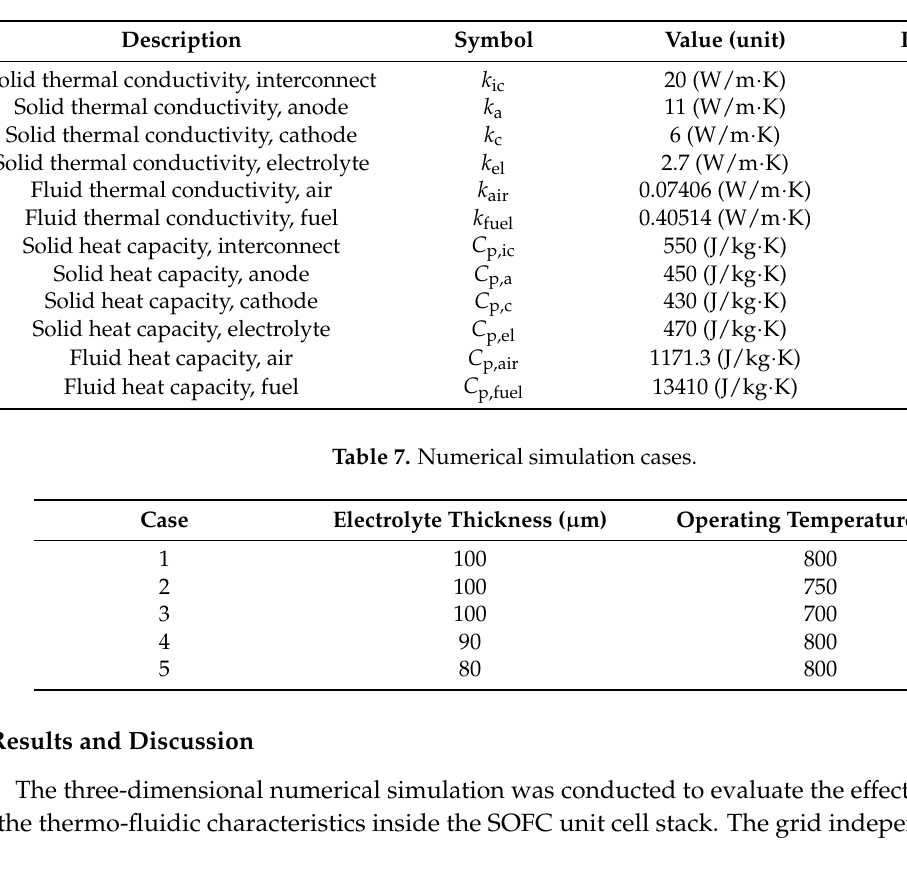
Table 6. Heat transfer parameters.